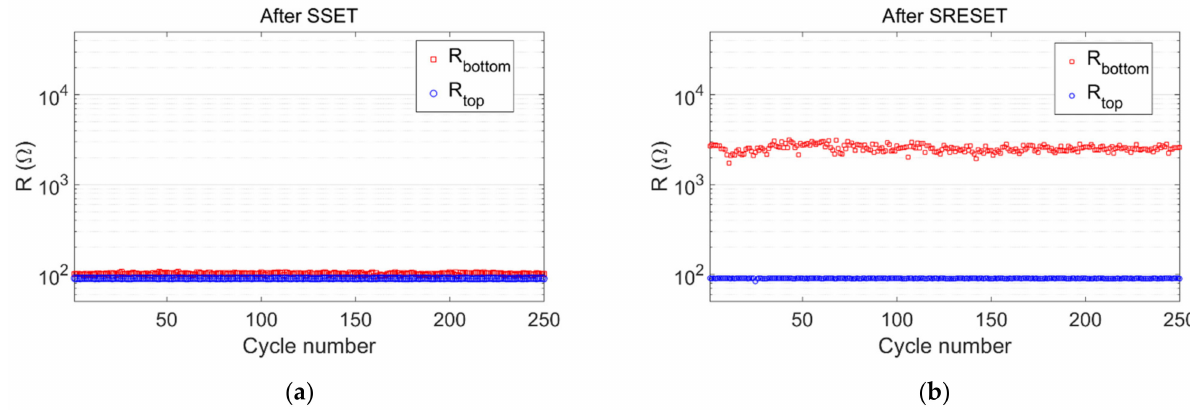
Figure 11. Measured resistances of a serial RRAM cell during a sequence of 250 serial operation cycles. No current compliance limit was imposed during SSET: ( a ) After masking (After SSET); ( b ) After unmasking (After SRESET).